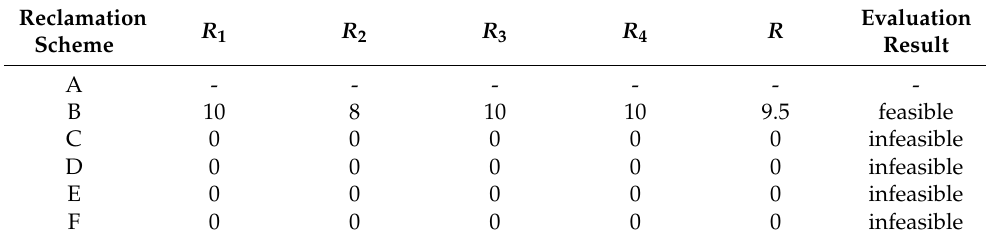
Table 9. Feasibility evaluation on EC (scenario 1).